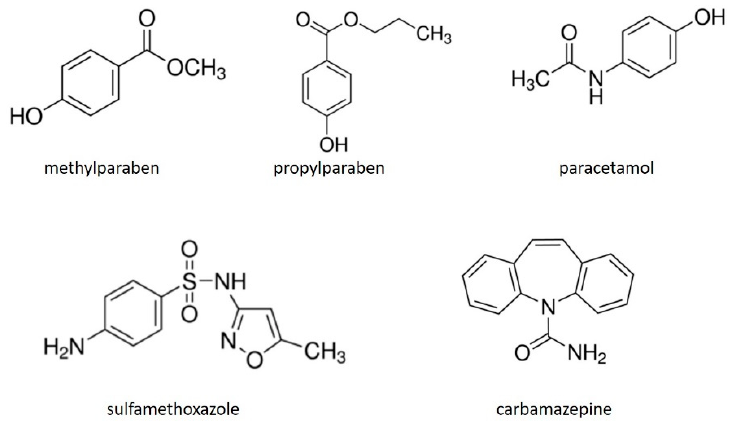
Figure 1. The chemical structures of the PPCPs used in the present study.